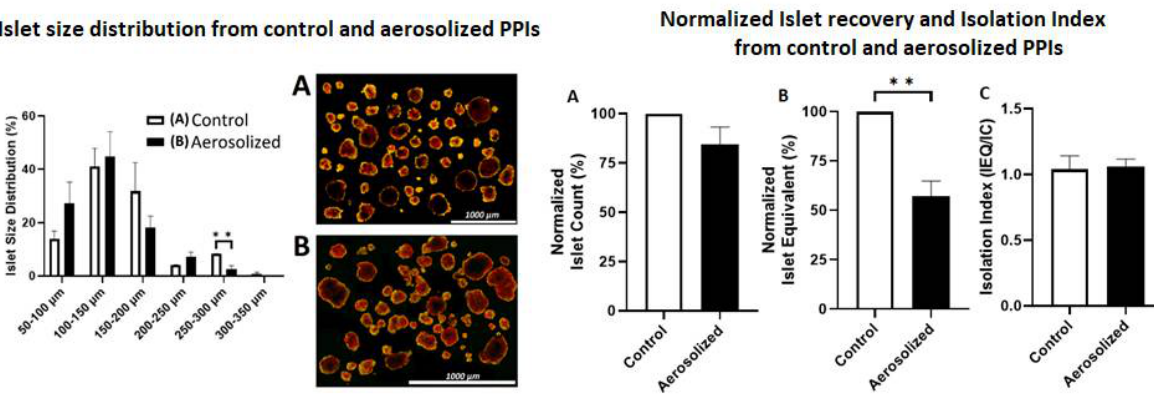
Figure 1. Size distribution and islet cell morphology before and after aerosolization. Left : Percentual size distribution (diameter in micrometer) of islets before (white column) and after aerosolization (black column). Right : light microscopy of islets before ( A ) and after ( B ) aerosolization. ** = p< 0.01.